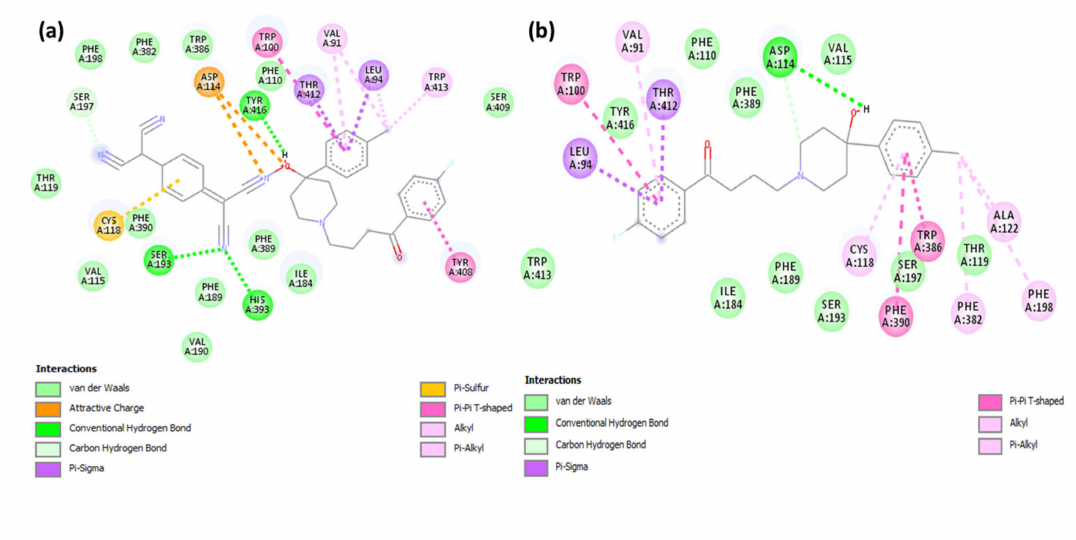
Figure 6. 2D representation of the interactions for dopamine docked with ( a ) CT complex and ( b ) HPL drug